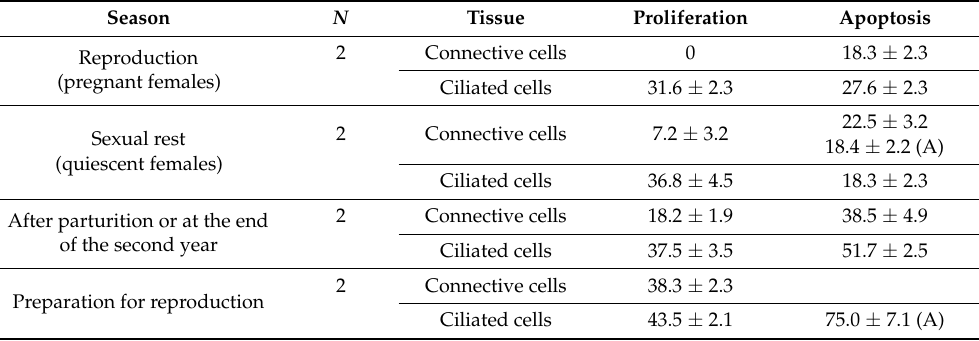
Table 6. Proliferation indexes (Ki67) and percentages of apoptotic cells (TUNEL/Apostain) in funnel of Typhlonectes compressicauda during the year. (A): apoptosis detected with Apostain method. N : number of females.